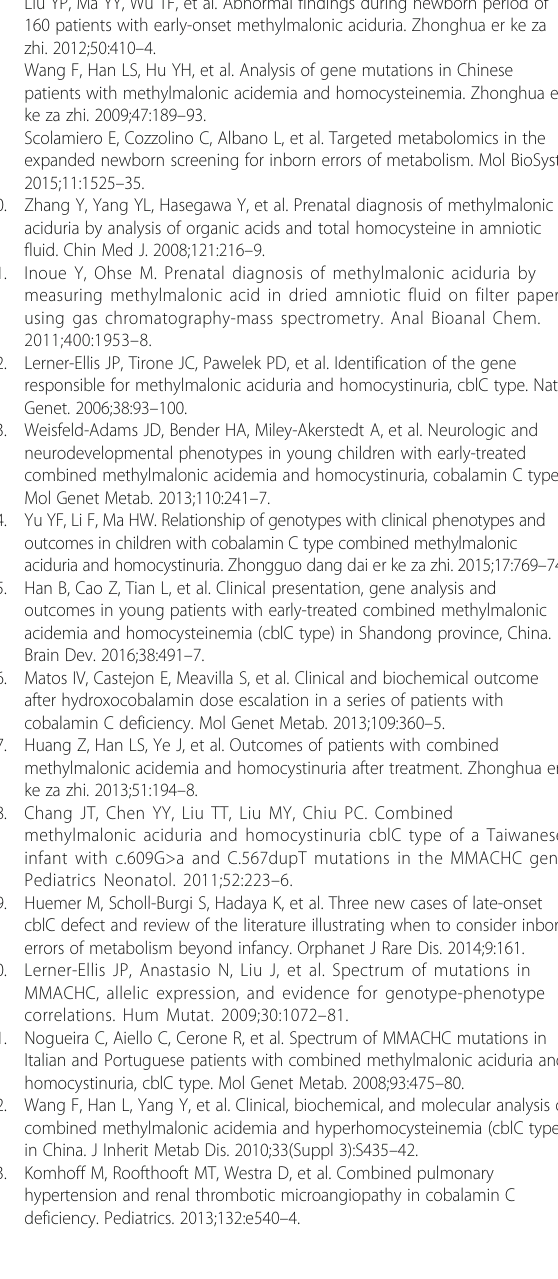
Additional file 1: Table S3 . The two allele variants of 126 pedigrees in our study. (DOCX 23